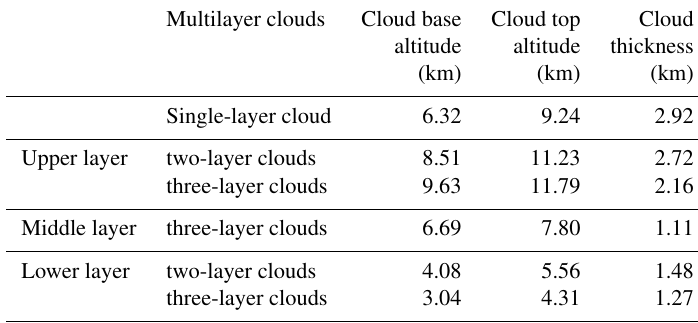
Table 2. Mean base, top, and thicknesses of cloud layers of single-layer, two-layer, and three-layer